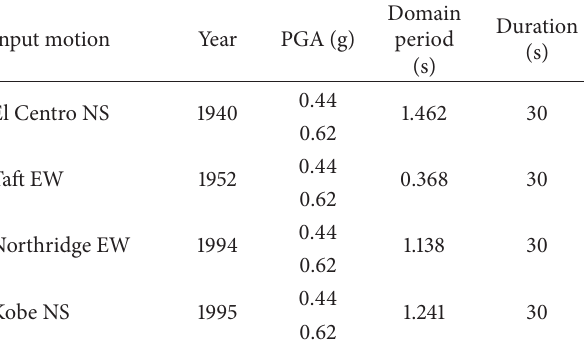
Table 5: Earthquake ground